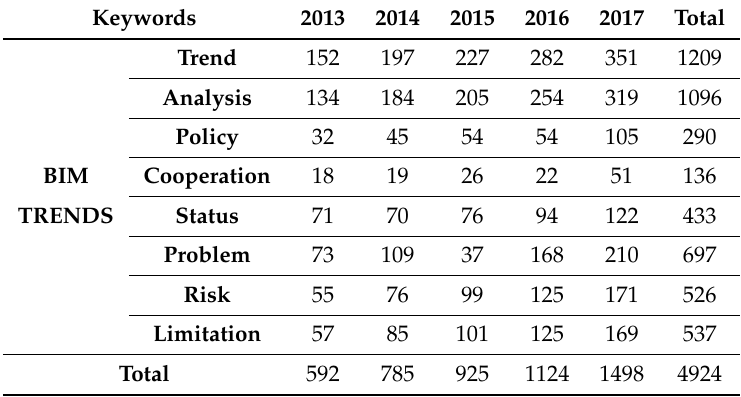
Table 1. International research trends related to building information modeling (BIM)